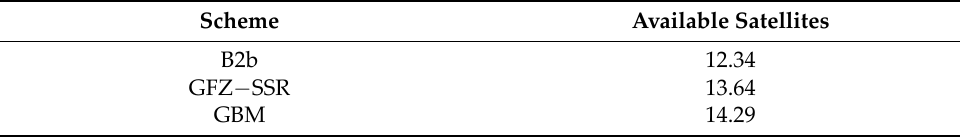
Table 3. Average number of available